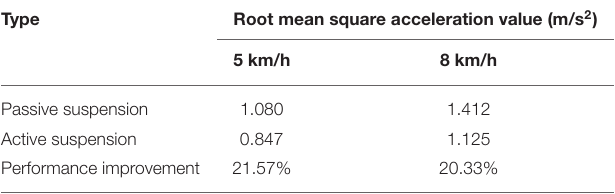
TABLE 5 | Different root mean square values of vibration acceleration when driving under field road excitation.